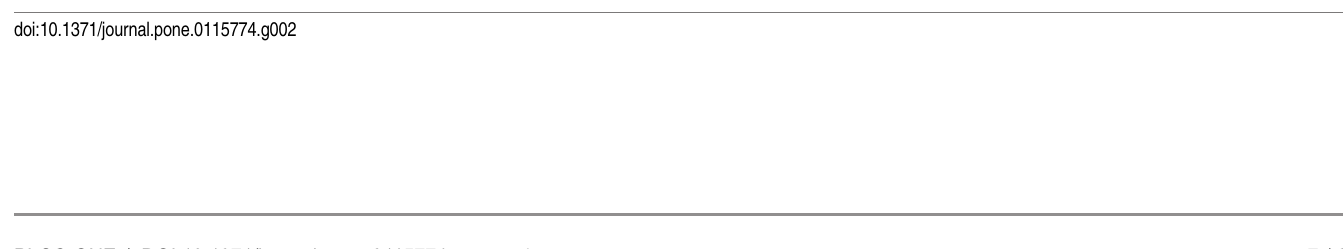
Fig. 2. Maximum intraspecific distance for the COI barcode region for the species in each of the 58 families. Left panel: Distributions of maximum intraspecific genetic distance values for each family. Right panel: Residuals from a regression of intraspecific distance against sample size per species, accounting for differences in sample size among